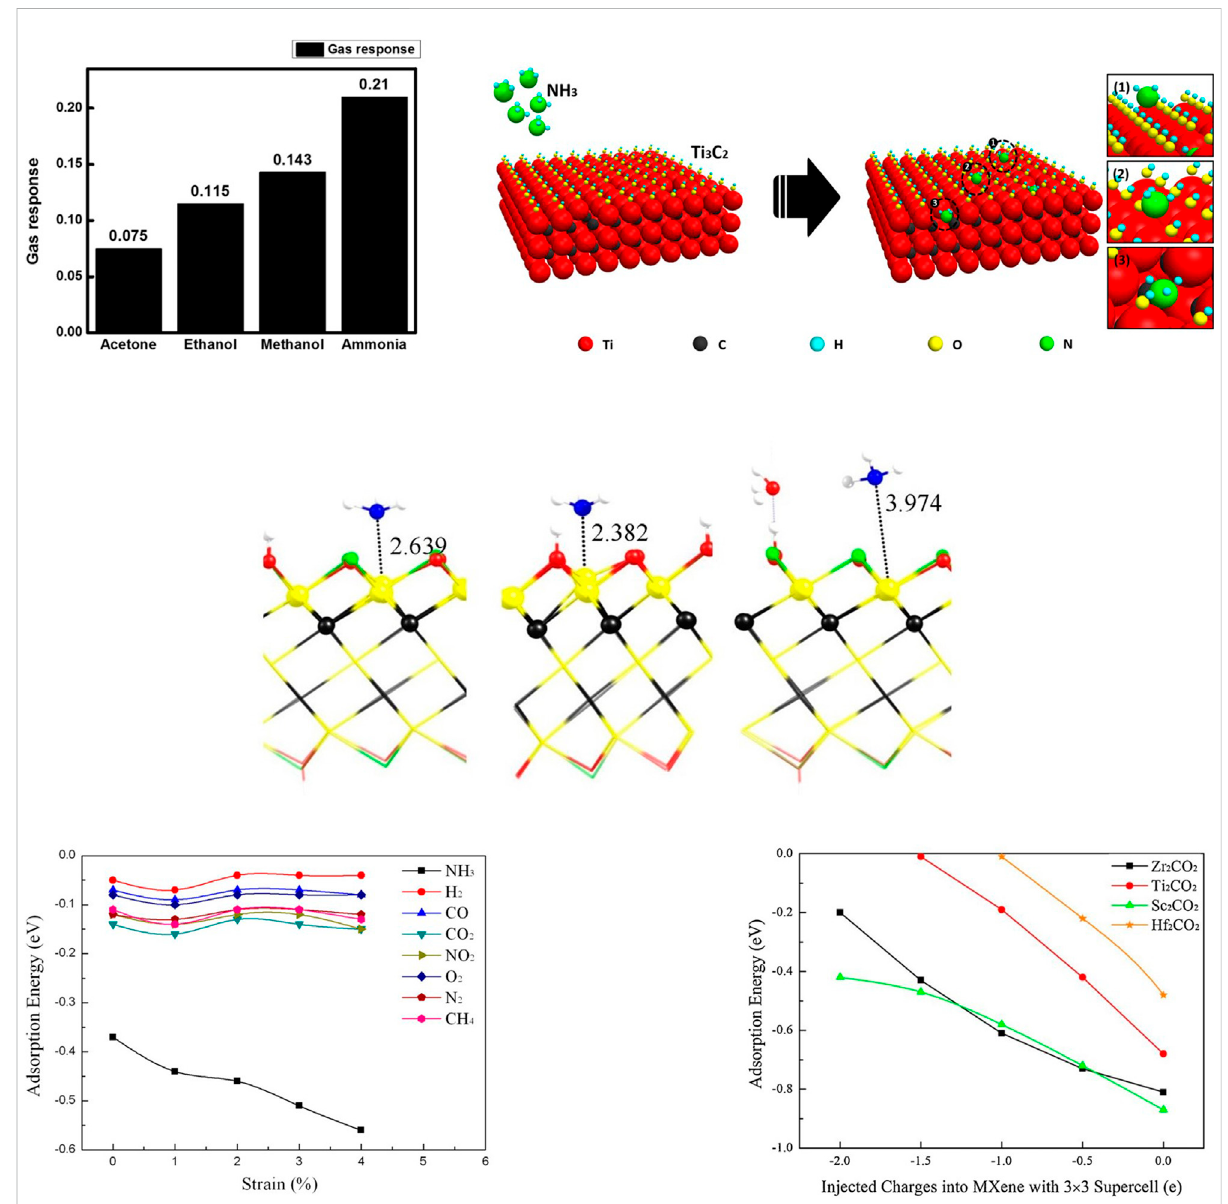
FIGURE 9 (A) Calculated average gas response of the Ti 3 C 2 T x MXene-based gas sensor for different gases, and schematic illustration of the possible gas- sensing mechanisms of the Ti 3 C 2 T x MXene for NH 3 gas, Reproduced with permission from Lee et al. (2017), ©American Chemical Society. (B) Side view of the adsorption structures of the NH 3 gas molecule on the surface of MXenes with different types of surface functional groups. Yellow, black, red, green, white, and blue atoms are titanium, carbon, oxygen, fl uorine, hydrogen, and nitrogen, respectively. Binding distances are in Å, Reproducedwith permission from Khakbaz et al. (2019), ©American Chemical Society. (C) Adsorption energies of gas molecules (including NH 3 , H 2 ,